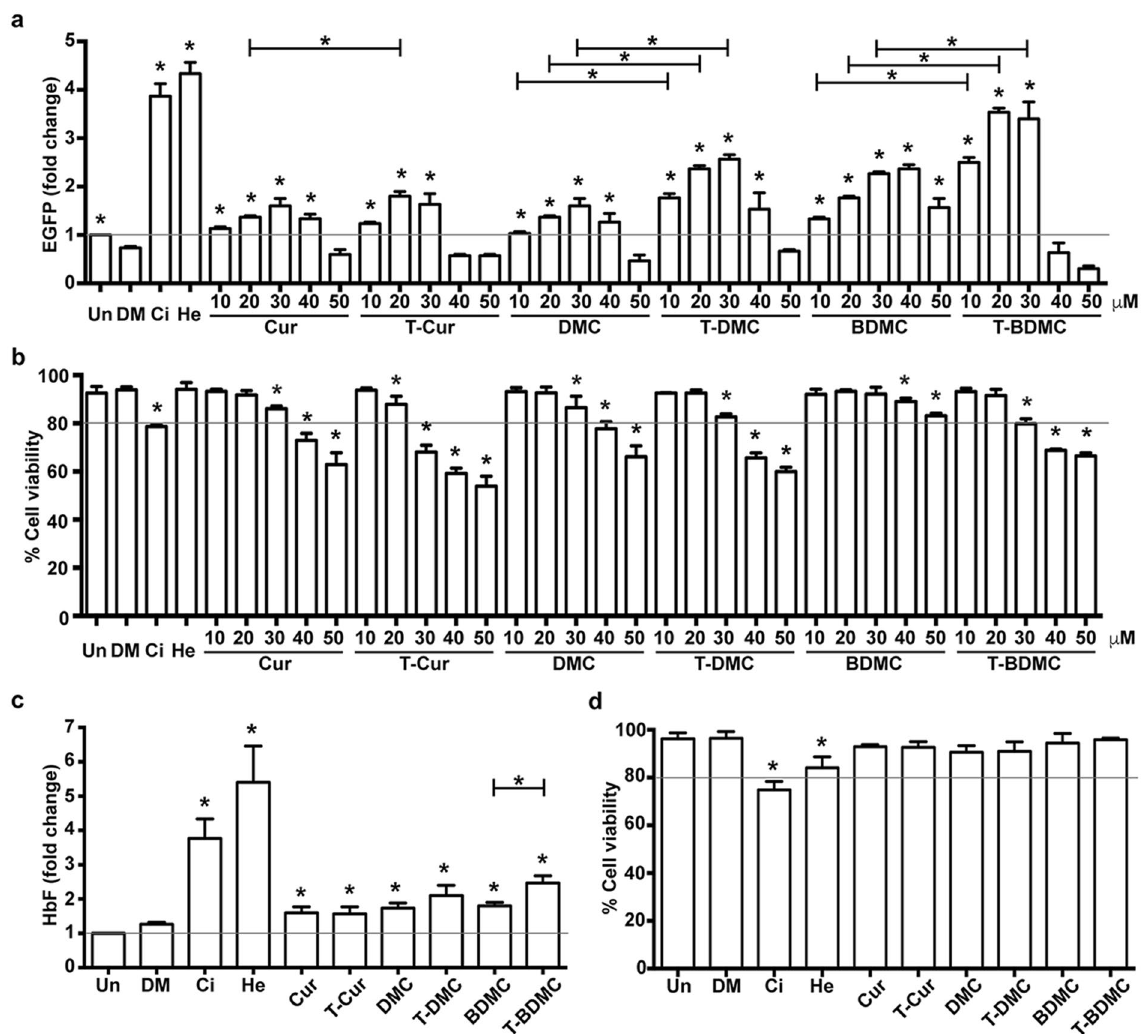
Figure 2. Curcuminoids and their trienone analogs induce HbF synthesis in K562 cells. K562::Δ G γ- A γ EGFP reporter cells and native K562 cells were treated with curcuminoids and their trienone analogs for 5 days. ( a ) EGFP expression and ( b ) cell viability of K562::Δ G γ- A γ EGFP reporter cells were analyzed by flow cytometry. Increased EGFP mean fluorescent intensity in a dose-dependent manner in treated cells compared with DMSO treated cells was observed. The concentration that yielding highest EGFP expression induction activity with more than 80% cell viability was selected for examined in native K562 cells. ( c ) HbF synthesis and ( d ) cell viability of native K562 cells were determined by flow cytometry. The results showed increased HbF synthesis in the compounds treated cells compared with the DMSO treated cells. Cisplatin (20 μM) and hemin (50 μM) were used as positive control. The fold changes in EGFP expression and HbF synthesis were compared with the untreated cells and showed as mean ± SD of three independent experiments. *, statistical significance when compared to DMSO treated cells or between groups at P < 0.05. Un, untreated; DM, DMSO; Ci, cisplatin; He, during ontogenesis. The methylation level and pattern are inversely related to γ-globin gene expression. Fetal stage erythroid cells predominantly expressed γ-globin with hypomethylation pattern while hypermethylation pattern was found in adult stage erythroid cells with low γ-globin expression 11 . To further assess whether HbF synthesis induced by the trienone compounds associated with DNA methylation, methylation status of the 4 CpG sites; − 53, − 50, + 6 and + 17 in both G γ-globin and A γ-globin promoters were determined by bisulfite conversion and pyrosequencing. At CpG − 53 and − 50 of G γ-globin promoter, DNA methylation of K562 cells treated with all six compounds was reduced to approximately 10%. Additionally, DNA methylation at CpG + 6 of G γ-globin promoter was decreased about 1–3% (Fig. 3). DNA methylation of K562 cells treated with T-BDMC at CpG − 53, − 50 and + 6 (9.3 ± 1.7%, 7.3 ± 1.7% and 5.3 ± 0.5%, respectively) was significantly lower than that of control cells (30.7 ± 3.8%, 25.0 ± 2.9% and 7.7 ± 0.9%, respectively) ( P < 0.05). In contrast, the six compounds have no effect on DNA methylation at the four CpG of A γ-globin promoter region (Supplementary Fig. 1). It is